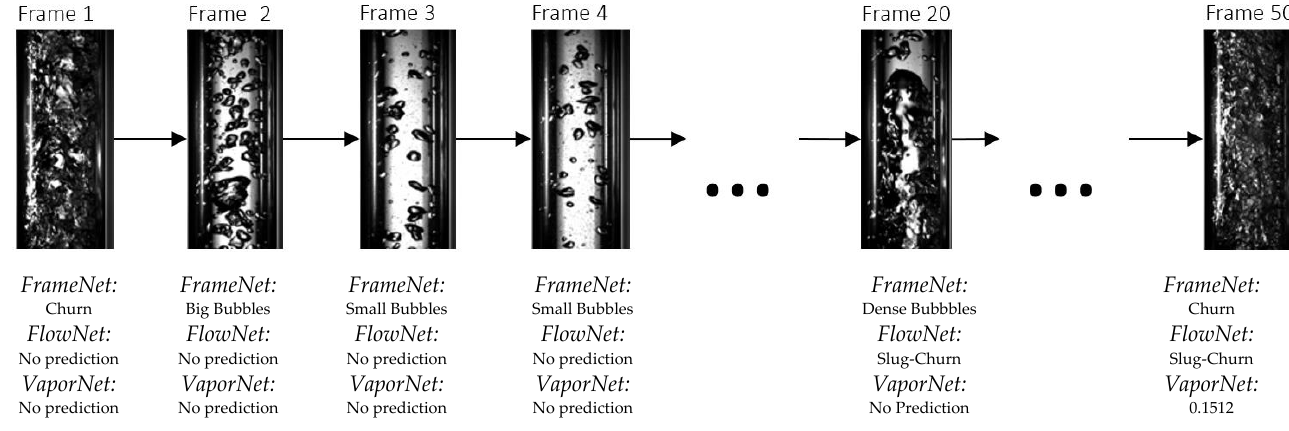
Figure 9. Example of model predictions across a sequence of frames.